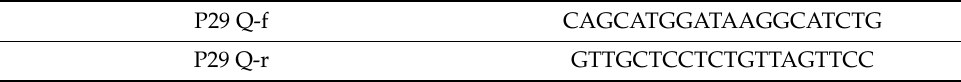
Table 1. Primer set used for real-time polymerase chain reaction (RT-PCR) in the present